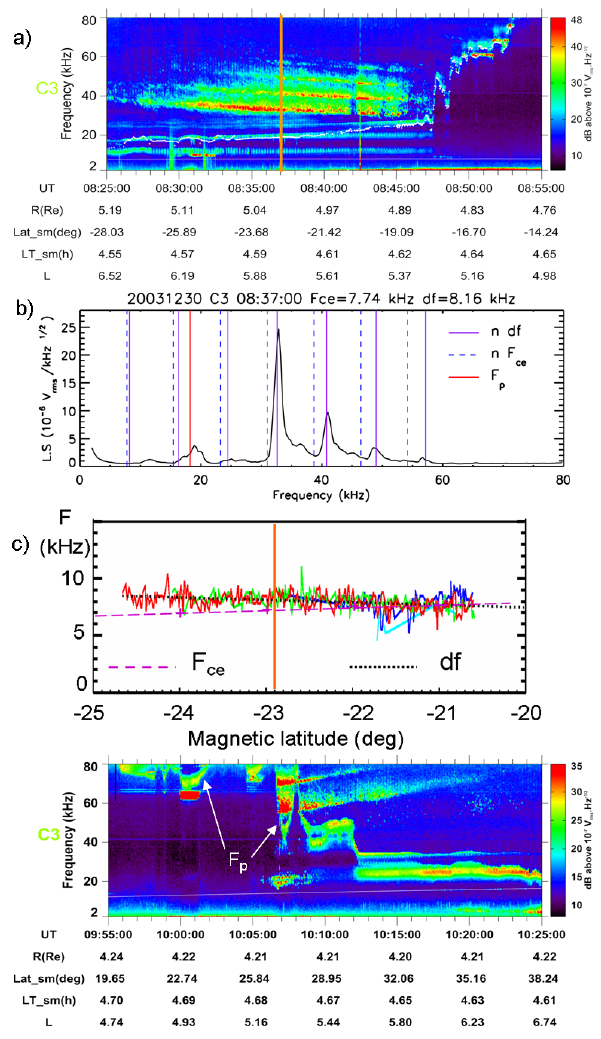
Figure 1. Spectral characteristics of the electric field measured by the C3 satellite of the Cluster constellation during the wide-banded NTC event of 30 December 2003. (a) Time–frequency spectro- gram when C3 enters the plasmasphere. A white dashed line fol- lows the plasma frequency F p and a white solid line the electron gyrofrequency F c e . (b) Individual frequency spectrum measured at 08:37:00UT (orange line in panels a and c ); the n df series is plotted as purple lines, the n F c e series as dashed blue lines. (c) Frequency distances df between two contiguous NTC peaks and F c e as a func- tion of magnetic latitude (Mlat). (d) Time–frequency spectrogram when C3 leaves the plasmasphere. White arrows point to F p spec- tral signatures.